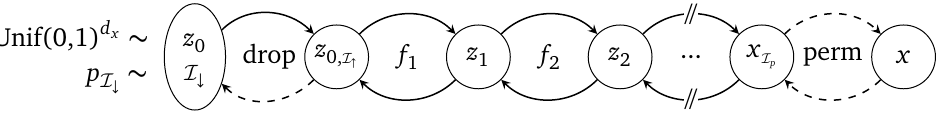
Figure 7: The dropout architecture described in section 3.4. The permutation trans- form can either be a stochastic permutation or a sort surjection, in which case the arrow in the inverse direction would be